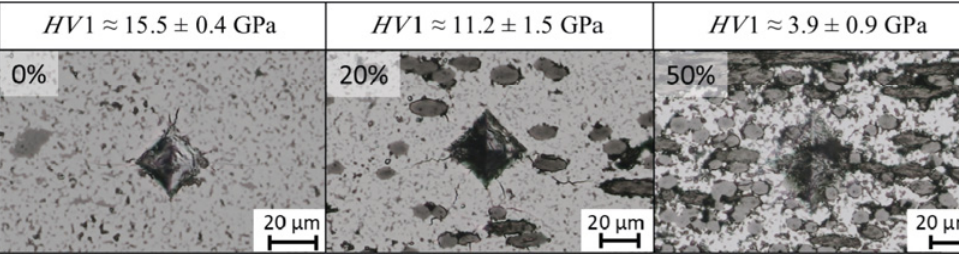
Fig. 12 Vickers hardness for three different parts of sample L1.